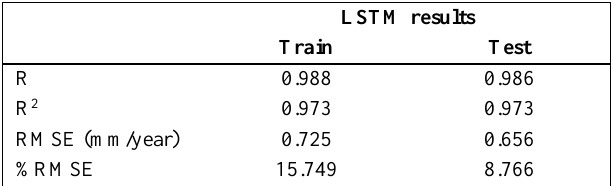
Table 2 . Results of the LSTM method In a previous study, Chen et al., (2021) compared prediction models for ENVISAT time series data, including LSTM, Multi- Layer Perceptron (MLP) and Recurrent Neural Network (RNN) models. They analysed displacement at Beijing Capital International Airport using images from 2005 to 2010 and found that the cyclic prediction model of LSTM produced the best results, with RMSE of 4.60